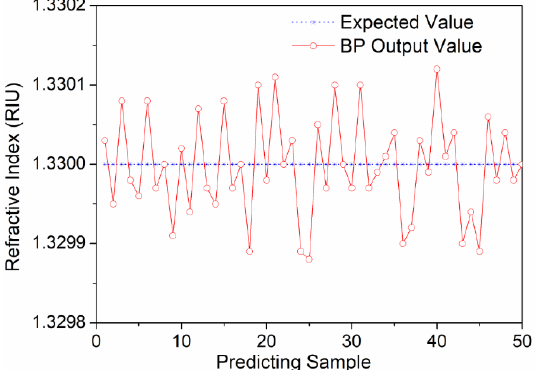
Figure 5. BP neural network result obtained by using the grayscale means of VIS and NIR images and RGB summation of the VIS and NIR edge detection images as input. The RI of the measured sample remained constant.